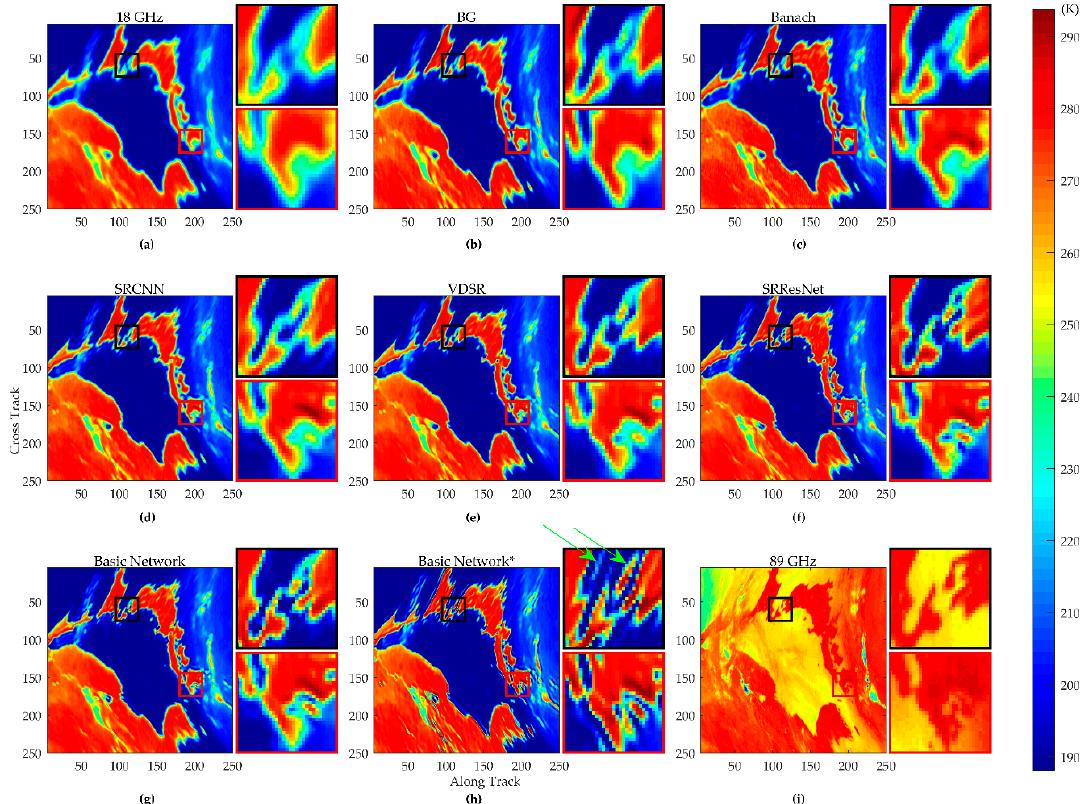
Figure 12. Resolution match results of real 18.7 GHz MWRI data. ( a ) Real 18.7 GHz antenna temperature image; ( b ) Match result of the BG method; ( c ) Match result of the Banach method; ( d ) Match result of SRCNN; ( e ) Match result of VDSR; ( f ) Match result of SRResNet; ( g ) Match result of basic network N b